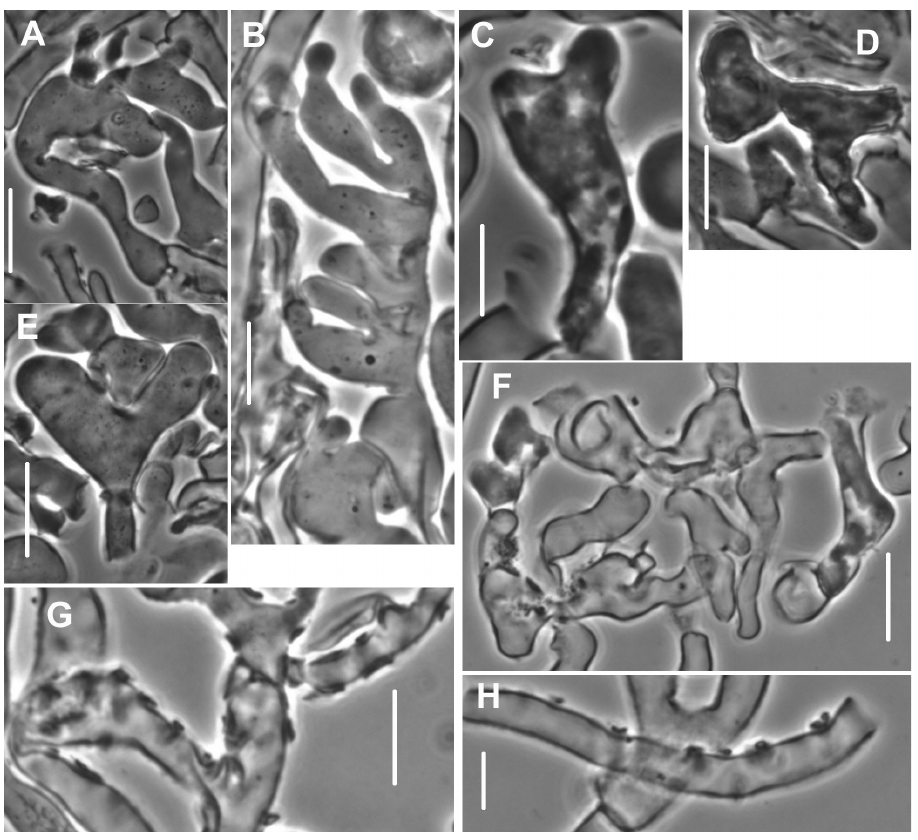
Figure 14. Mycetinis applanatipes . Pileipellis and subpellis structures. A, B, E Complex lobate hyphal termini C, D Thick-walled, strongly pigmented elements F Loosely complex pileus tramal hyphae G Encrusted hyphae H Detail showing spiculate crust material. Standard bars = 10 µm. DED 6628 (SFSU-F- 024637).